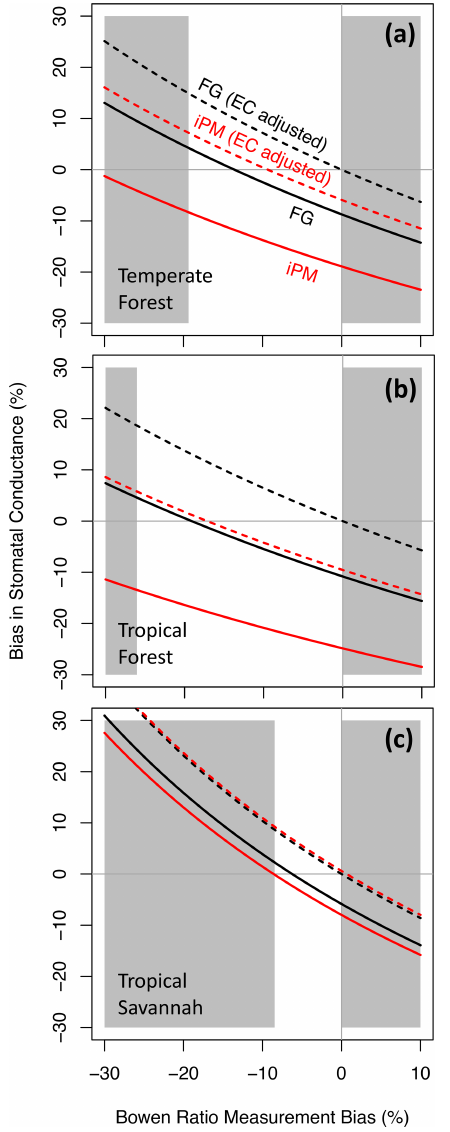
Figure 4. Proportional bias in canopy stomatal conductance ob- tained from the flux–gradient (FG, black) and inverted Penman– Monteith (iPM, red) formulations versus proportional bias in the es- timated boundary layer resistance. Solid lines show results without eddy flux correction, and dashed lines show results with perfectly corrected eddy